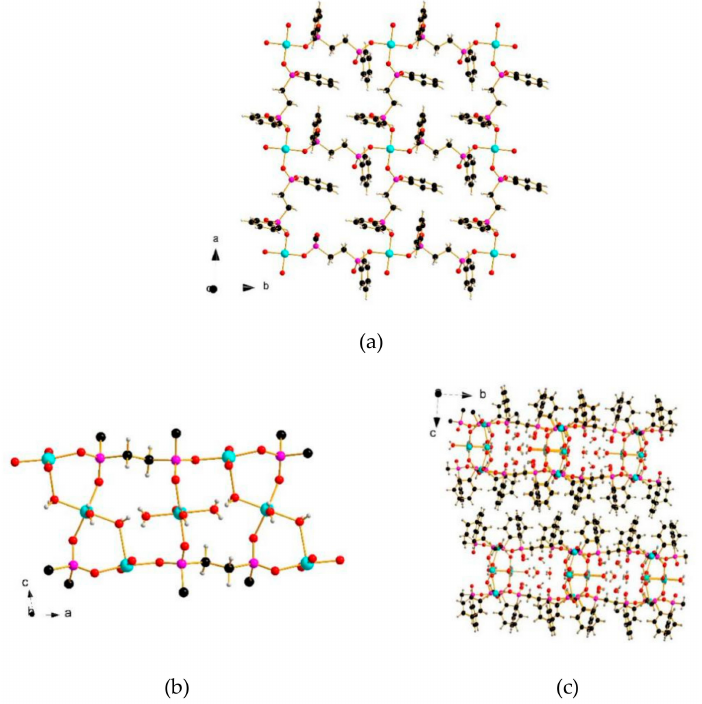
Figure 2. ( a ) Square grid formed by Cu1 and pc 2 p ligands; ( b ) strips formed by by Cu1, Cu2 and Cu3 metal ions along a axis; ( c ) the packing of the 2D layers along the c axis. Color code: Cu turquoise, P purple, O red, C grey, H